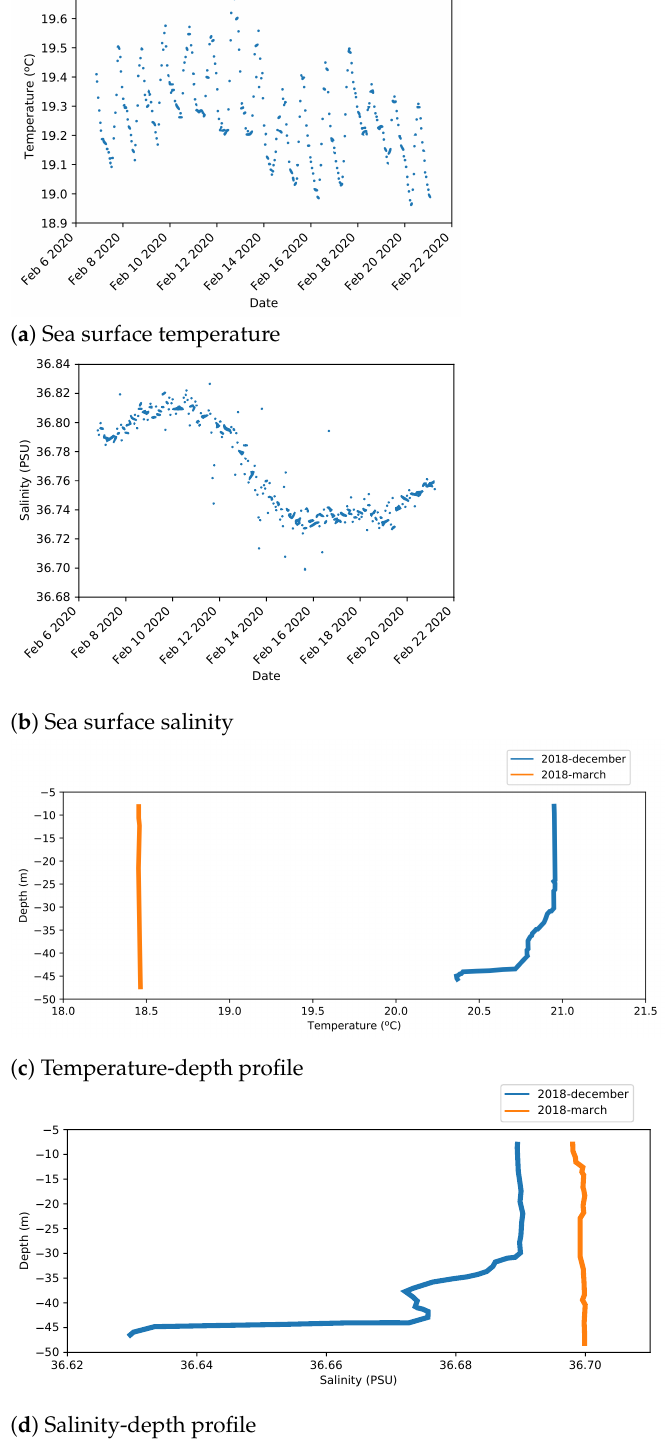
Figure 9. Real measures from the Platform of the Canary Islands (PLOCAN). Figure 9c,d shows the variation of these magnitudes according to